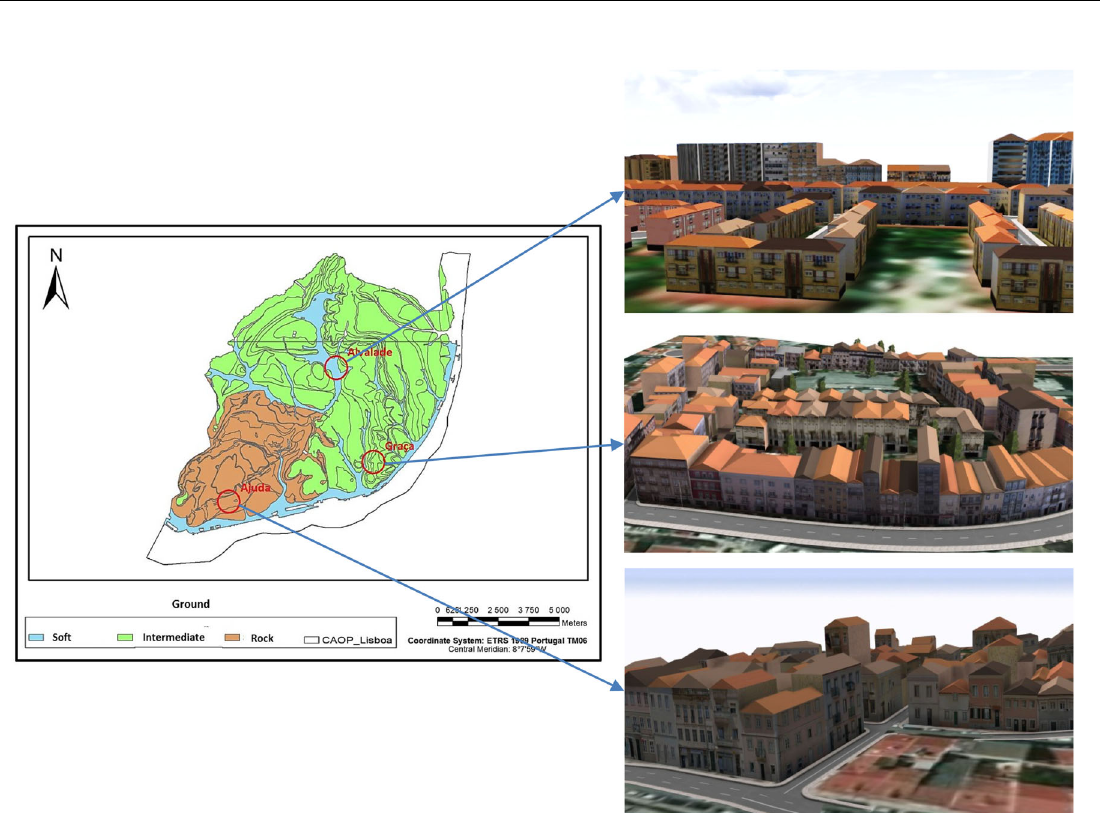
Fig. 6 Pilot areas location and views of the respective 3D model (actual state